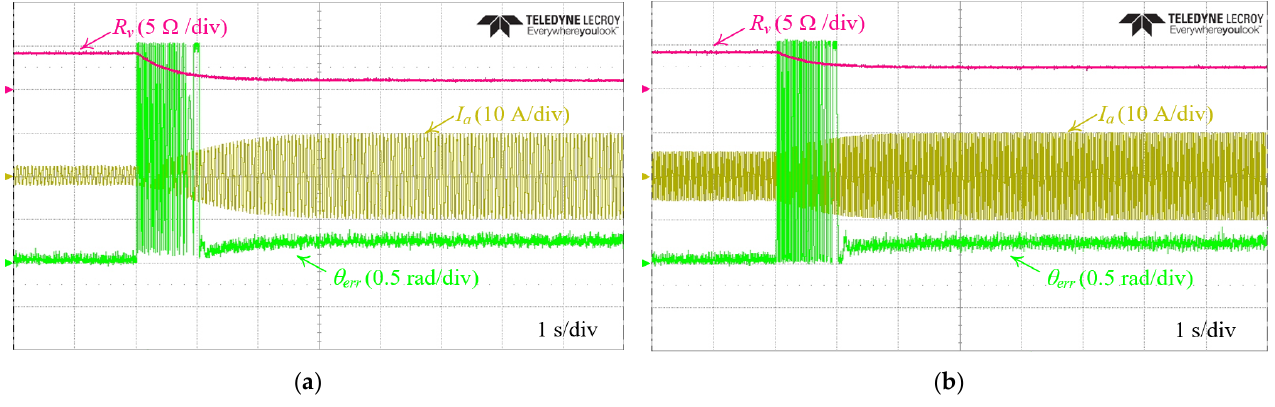
Figure 15. Experimental results of the conventional method and its position estimation error at 500 rpm and 1000 rpm. ( a ) R v , I a , and θ err at 500 rpm and ( b ) R v , I a , and θ err at 1000 rpm. However, after starting the estimation current regulator, is 0.23 rad (7.3% of maximum position error) in the steady state for position estimation because of the as- sumption error.